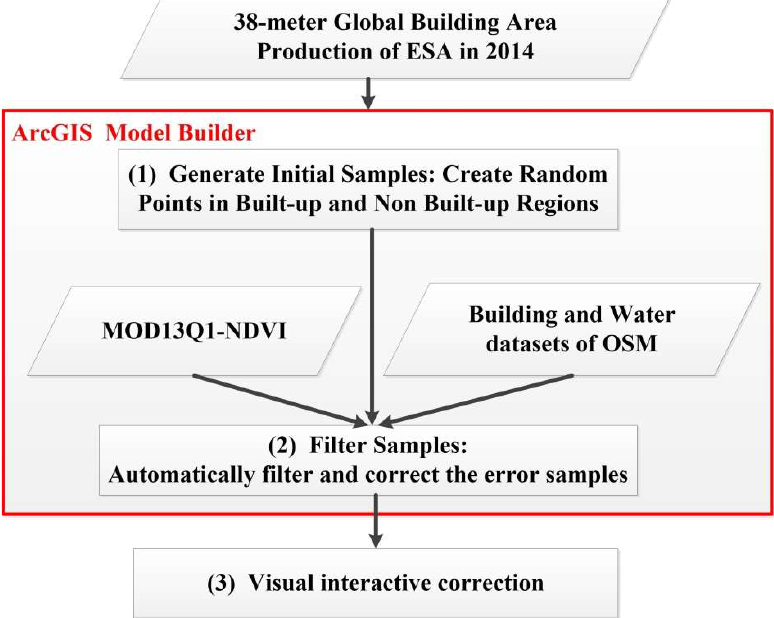
Figure 2. Sample generation and correction. ESA: European Space Agency; OSM: OpenStreetMap.